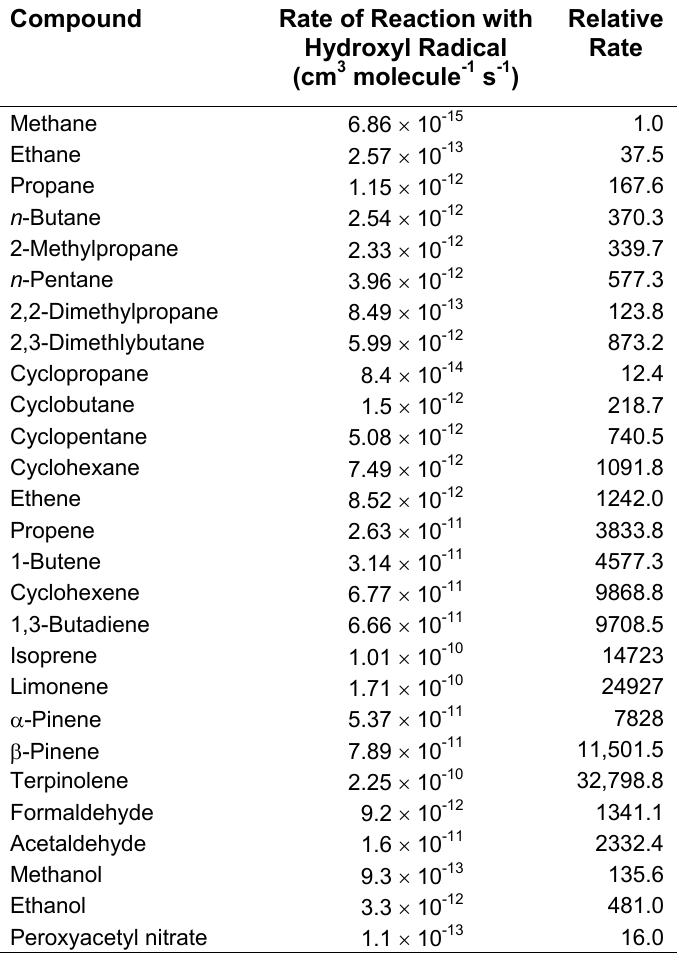
Gas-Phase Hydroxyl Radical Reactivities of Some Important Volatile Organic Compounds